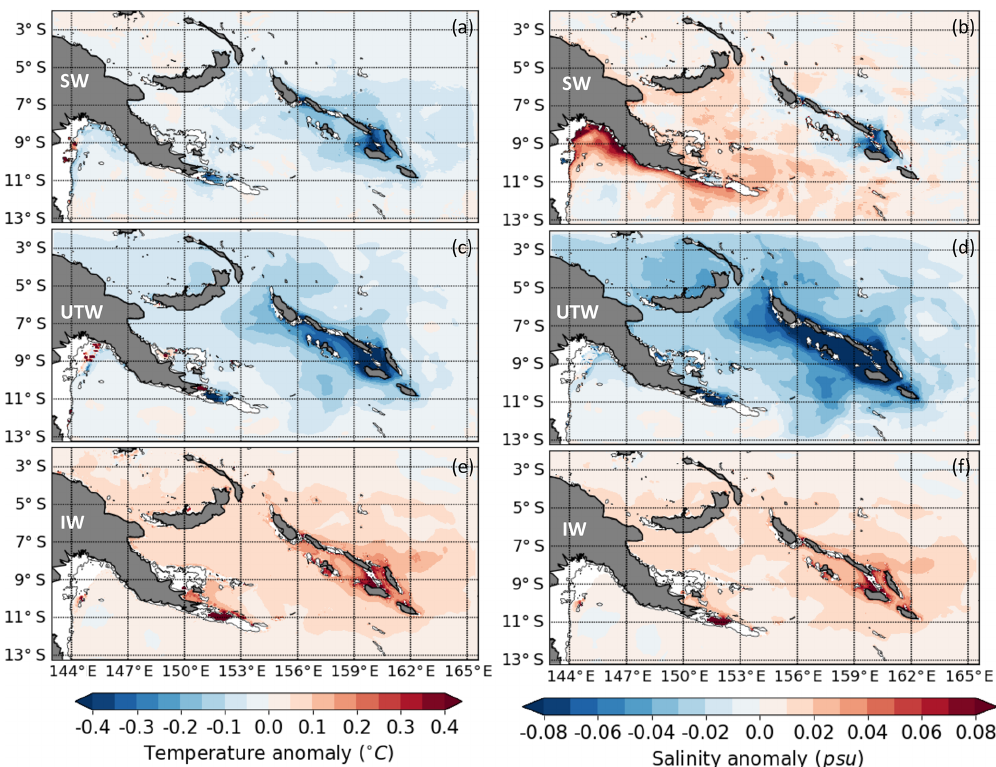
Figure 13. Mean difference in (a, c, e) temperature (units: degrees Celsius) and (b, d, f) salinity between the simulation with tides and the simulation without tides (TIDES-NOTIDES) for (a, b) the surface waters (SW), (c, d) the upper thermocline waters (UTW), and (e, f) the in- termediate waters (IW). The density range for these water masses are defined in the text. Isobathymetric lines are from the NOAA/ETOPO2v2 bathymetric file from the Smith & Sandwell database (https://doi.org/10.7289/V5J1012Q, National Geophysical Data Center, 2006). White color is for bathymetry of less than